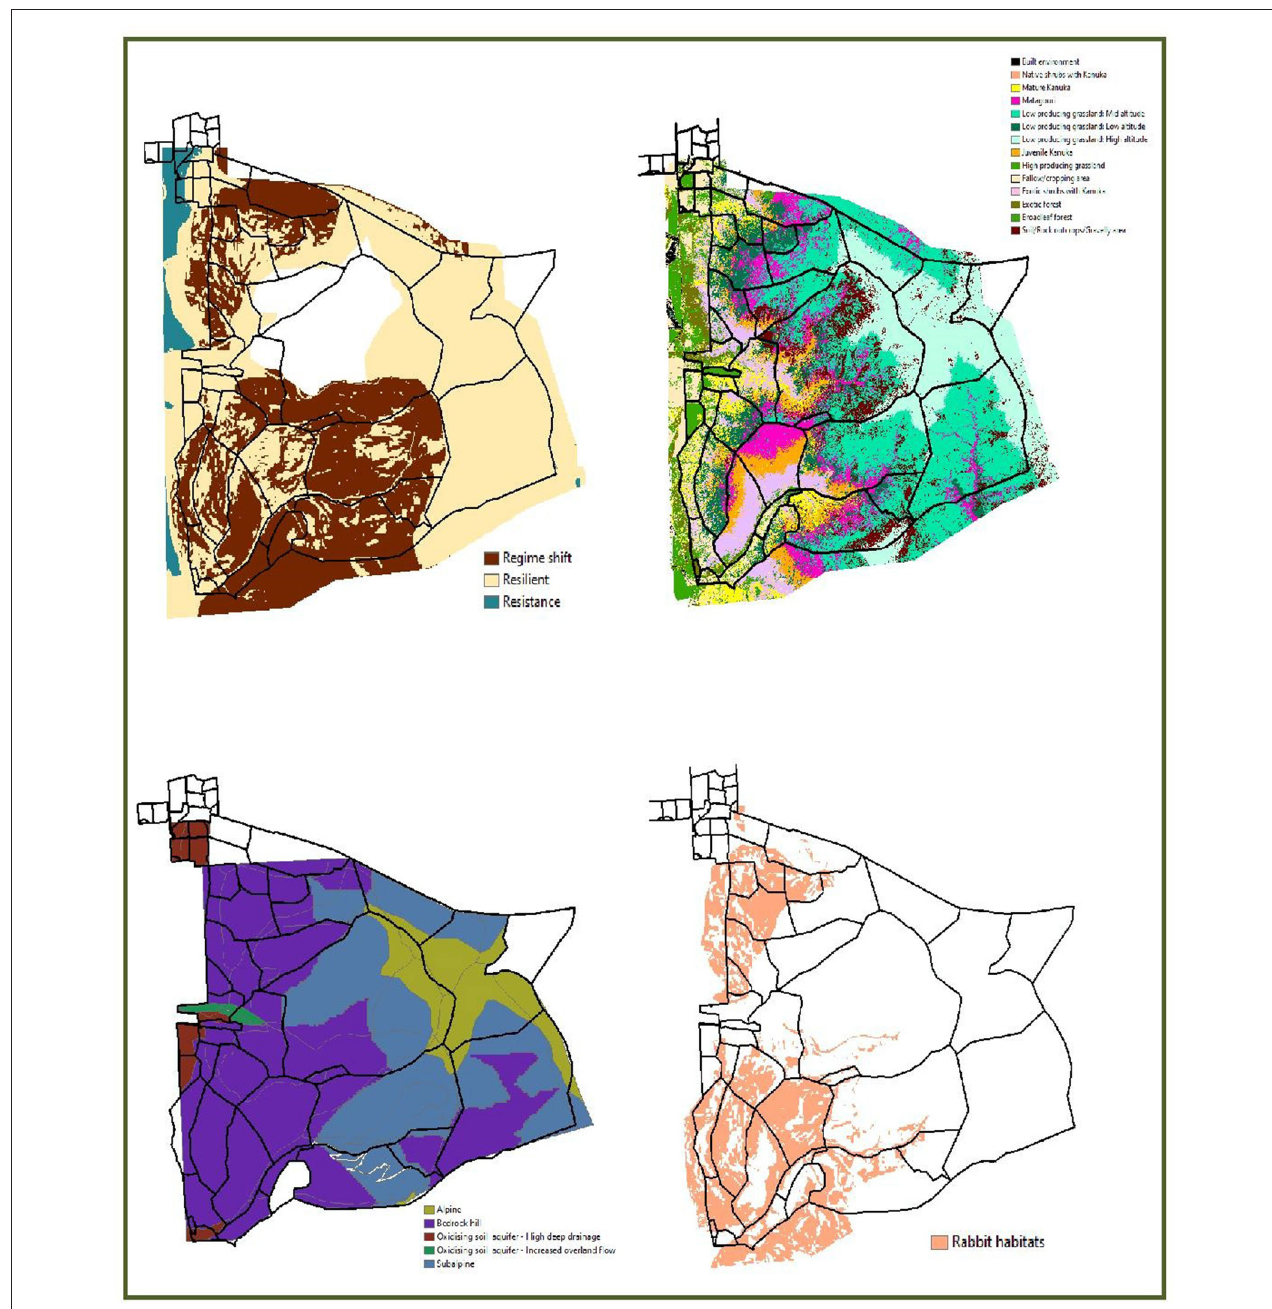
FIGURE 8 | Farm scale mapping of key pastoral and landscape health